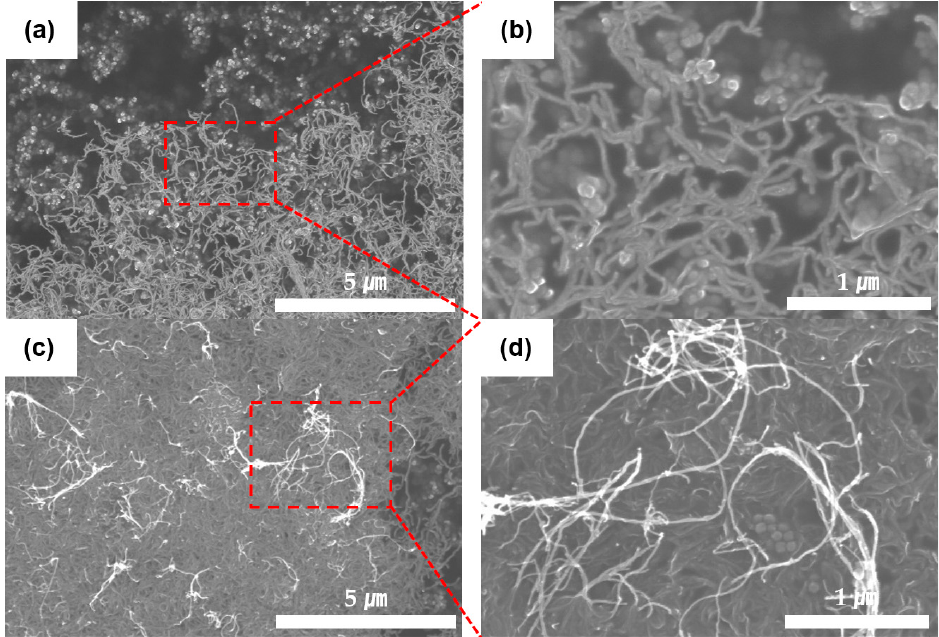
Figure 1. SEM micrographs of ( a , b ) as-received MWCNTs (length: 100 µm) and ( c , d ) chopped MWCNTs (length: 5–10 µm).